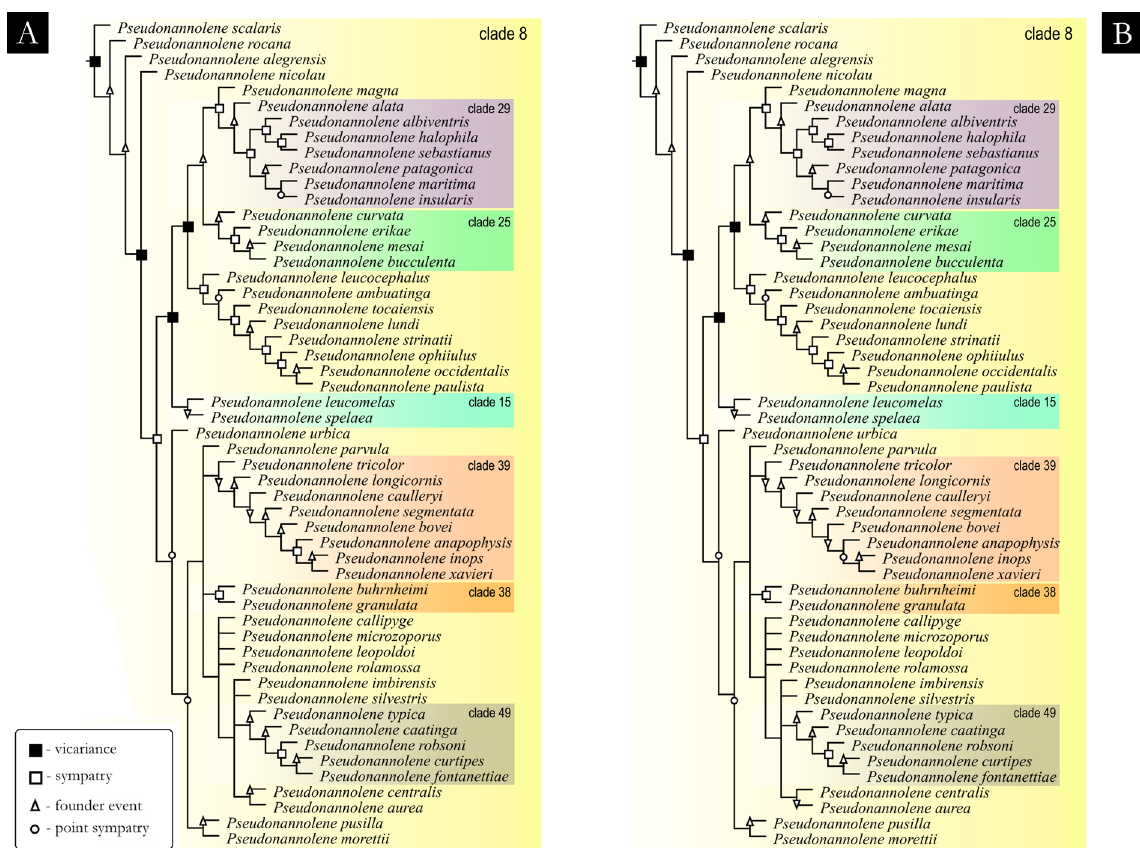
Fig. 14. The equally parsimonious optimal reconstructions of the biogeographic history inferred for Pseudonannolene Silvestri, 1895 using GEM. The reconstructions A and B were based on the majority rule consensus tree. The symbols refer to the cladogenetic events recovered: white triangle = founder event; white squares = sympatry, black square = vicariance; white circle = point